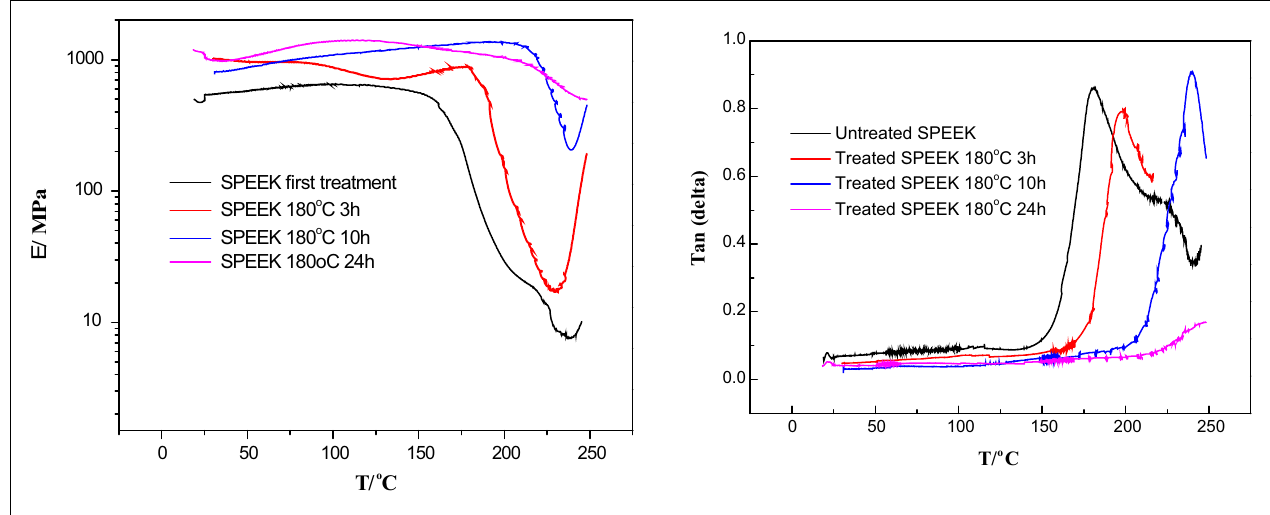
FIGURE 5 | Dynamic mechanical analysis of SPEEK membranes is shown . Left : storage modulus vs. temperature, right : phase angle (tan δ ) vs. temperature.